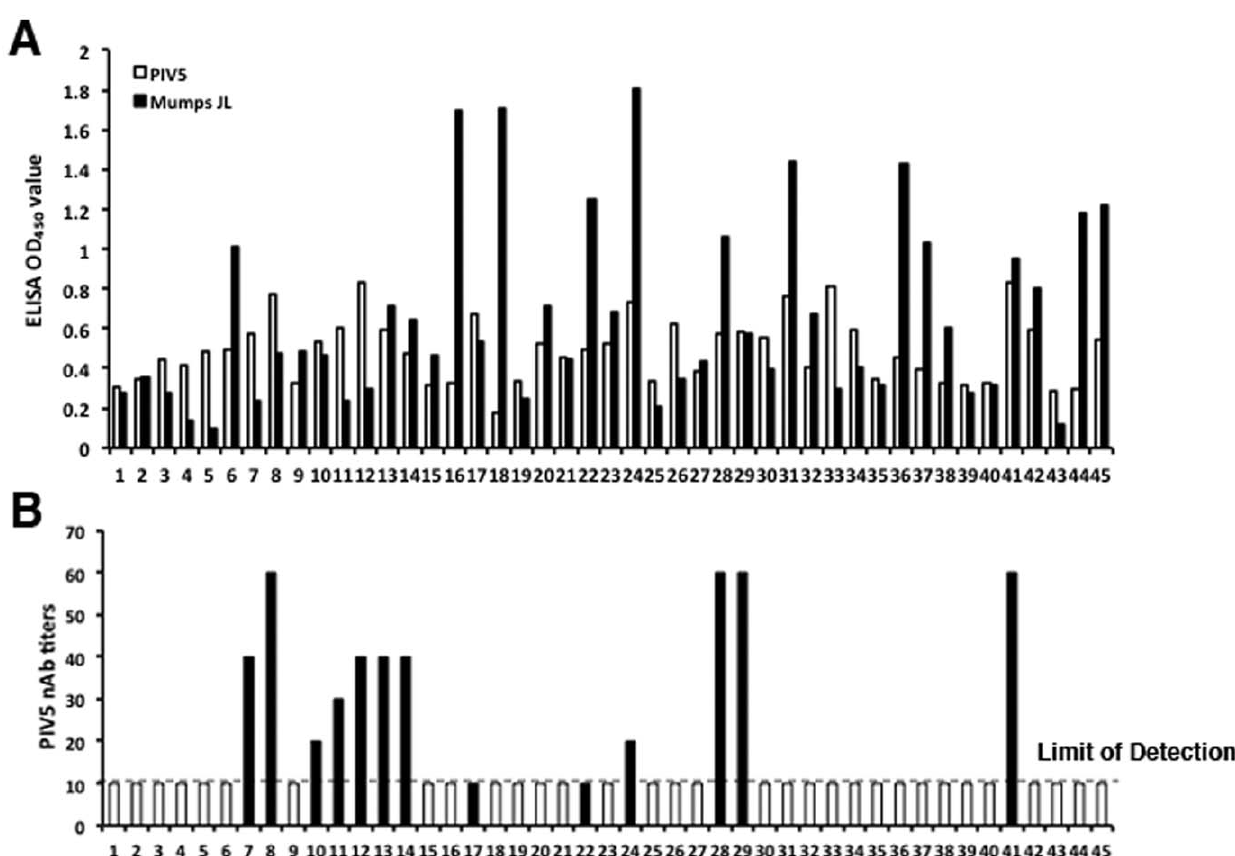
Figure 7. PIV5 antibodies in humans. 45 human serum samples were obtained from 18–50 year old healthy individuals. (A) Comparison of anti- PIV5 and anti-MuV antibody levels. ELISA was performed on plates coated with purified PIV5 or purified MuV with sera serially diluted. PIV5 or Mumps virus specific ELISA OD 450 values were shown at 320-fold dilution for each human serum sample. (B) Titers of neutralizing antibody against PIV5 in human sera. Data for the antibody titers were the average value of duplicate wells and presented for each human sample. The white column indicates that the PIV5 nAb titer is less than 10, the limit of detection. The black column indicates that the nAb titer is equal to or higher than 10.